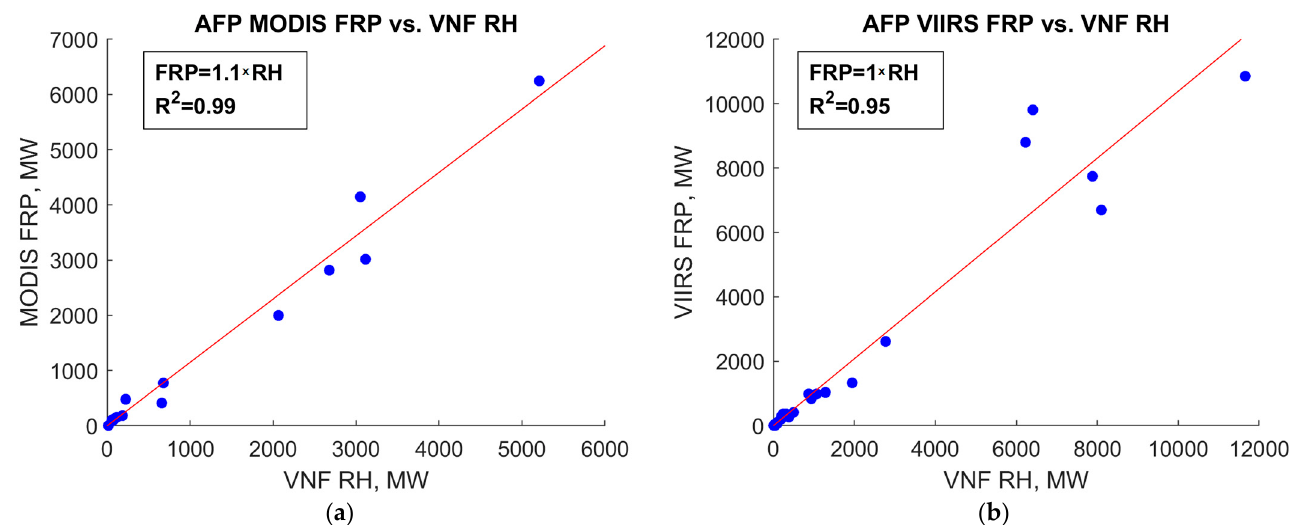
Figure 17. Comparison of VNF and AFP by radiative power from forest fires: ( a ) VNF vs. MODIS AFP; ( b ) VNF vs. VIIRS AFP. AFP; ( b ) VNF vs. VIIRS